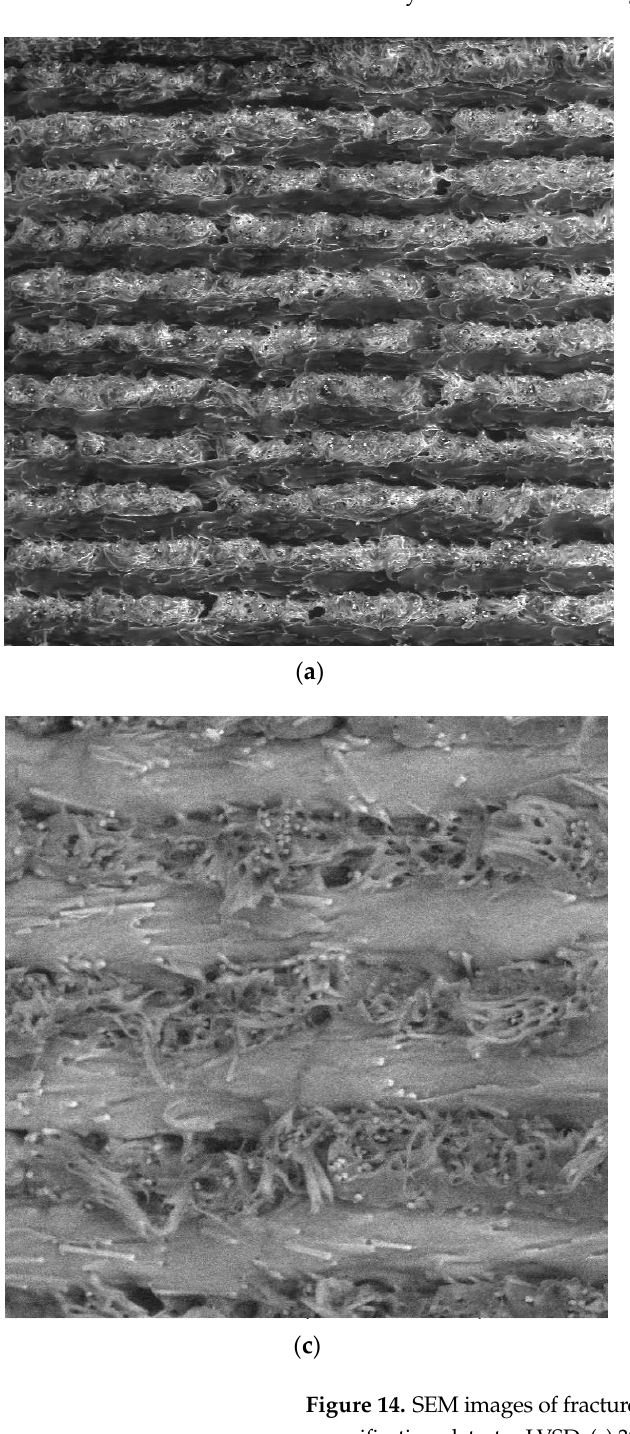
Figure 13 . Detail of fracture: ( a ) 0/90 infill strategy; ( b ) 45/ − 45 infill strategy. Green arrows present the orientation of the solid infill in the top layer.